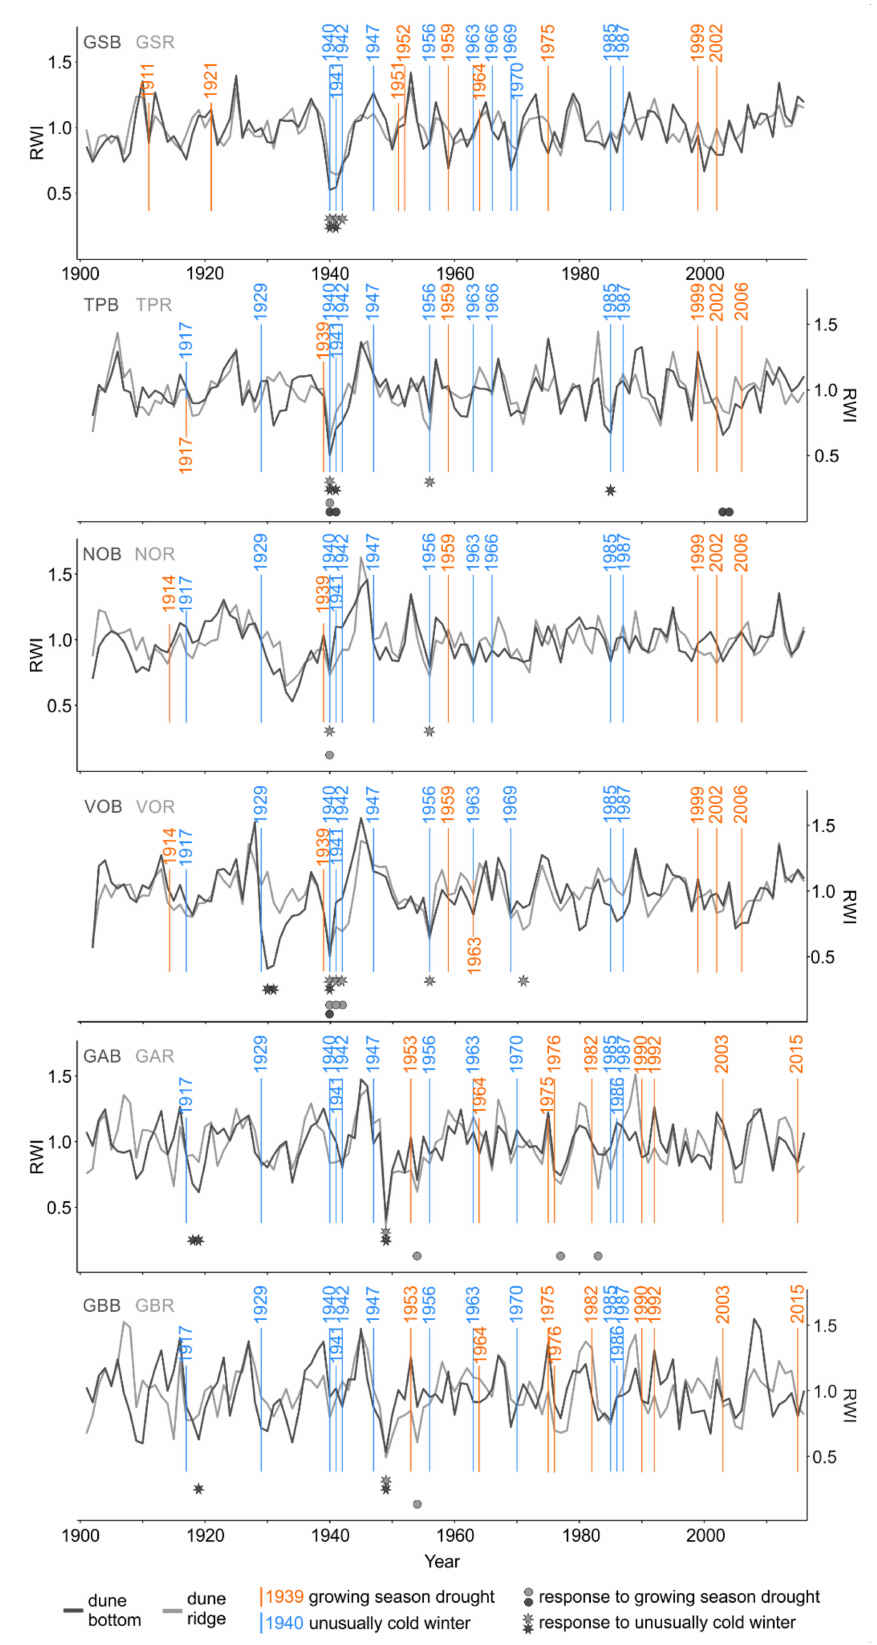
Figure 4. Standardized microsite ring-width chronologies (dune bottom = dark gray line and dune ridge = light gray line), individual site-specific droughts (orange vertical lines), and cold